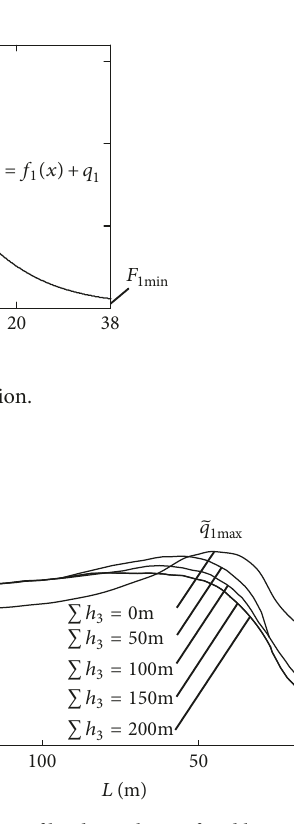
Figure 6: Relation of loads on the roof and buried depth